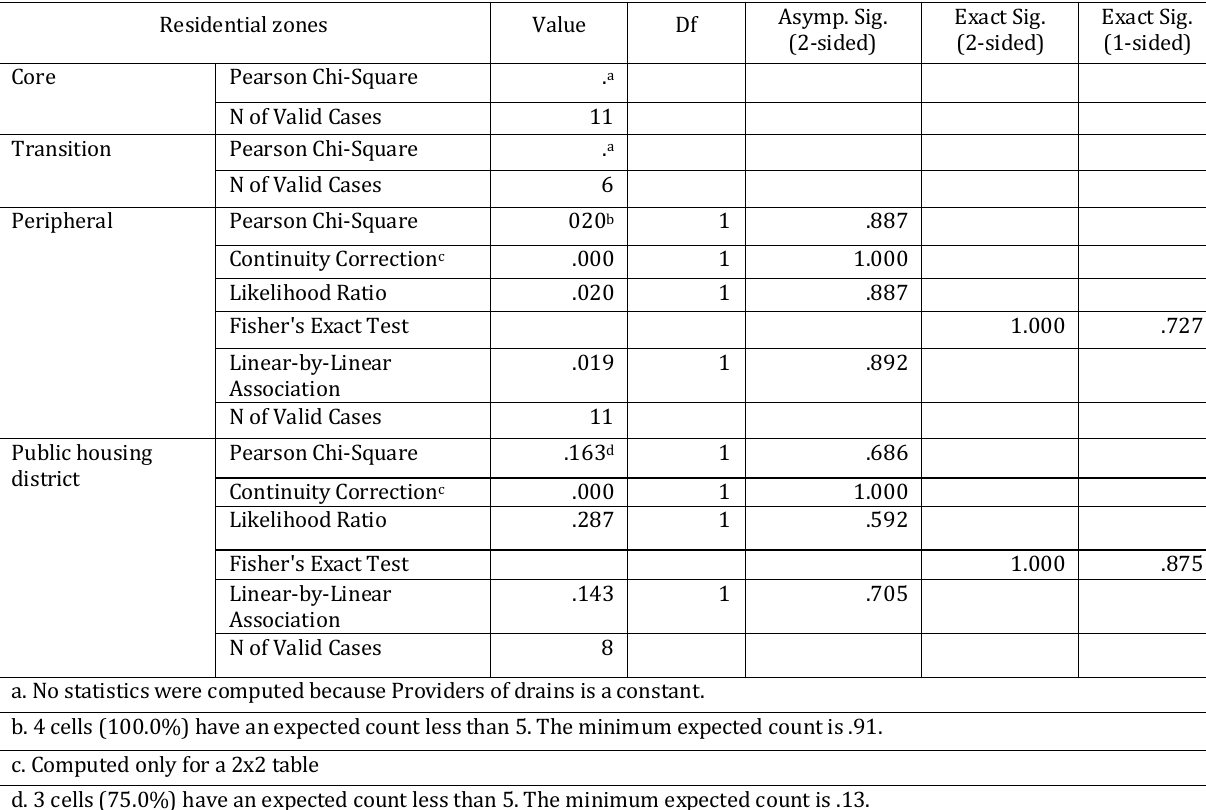
Table 8. Chi-Square summary for providers of drains across residential